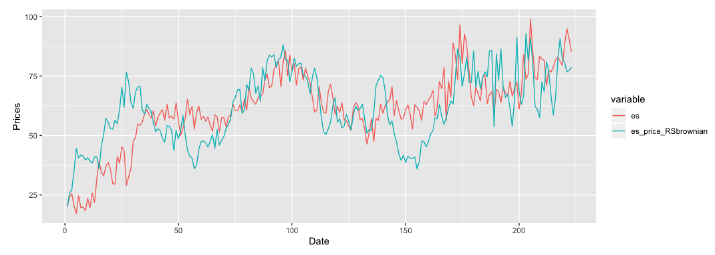
Figure 11. Simulation Result of RSOU model on energy-switching data.